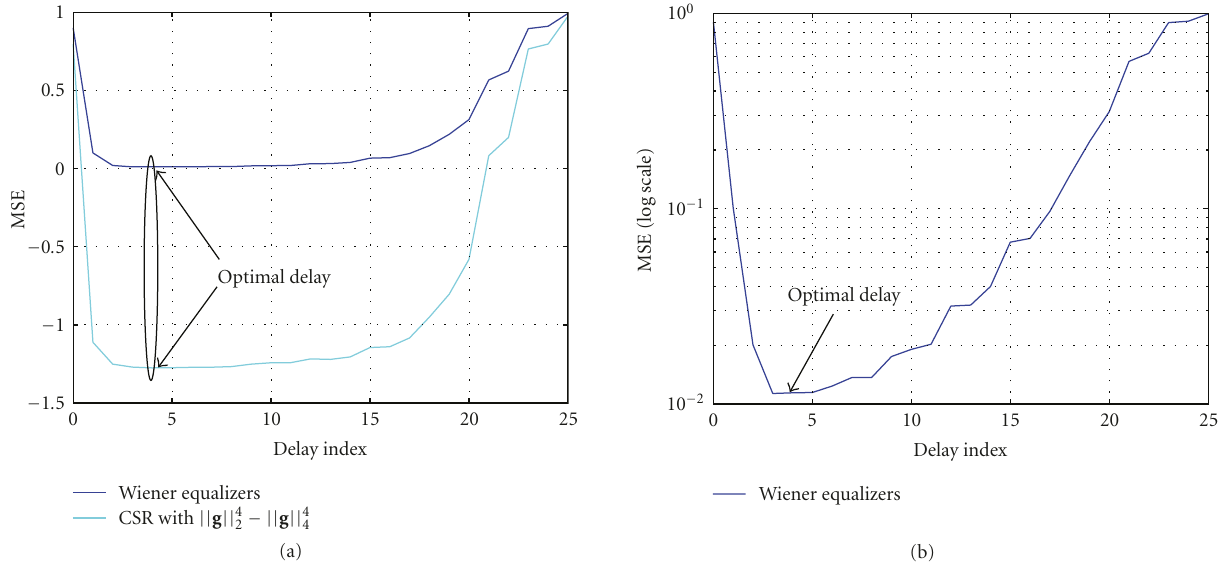
Figure 4: MSE versus system delays for (a) Wiener equalizers and logarithmic view for (b) Wiener